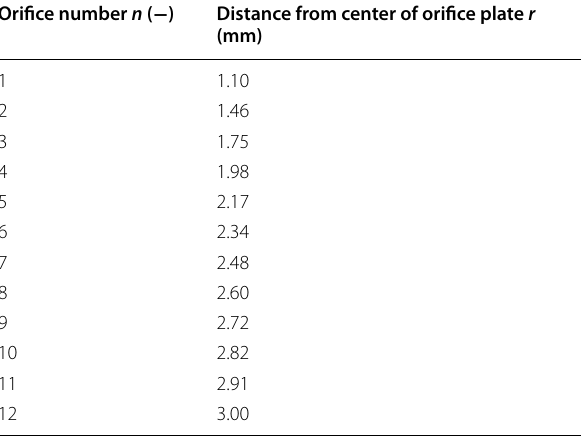
Table 1 Relationship between orifice number and distance from center of orifice